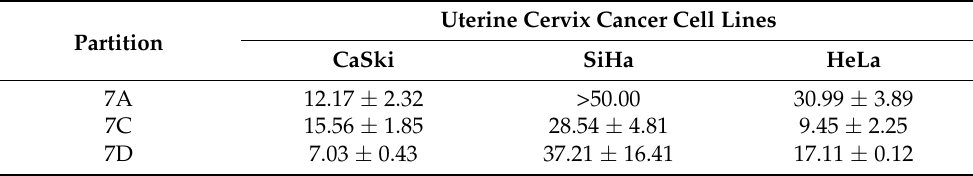
Table 3. IC 50 values ( µ g/mL) 1 of A. crassiflora partitions in human cervical cancer cell lines.